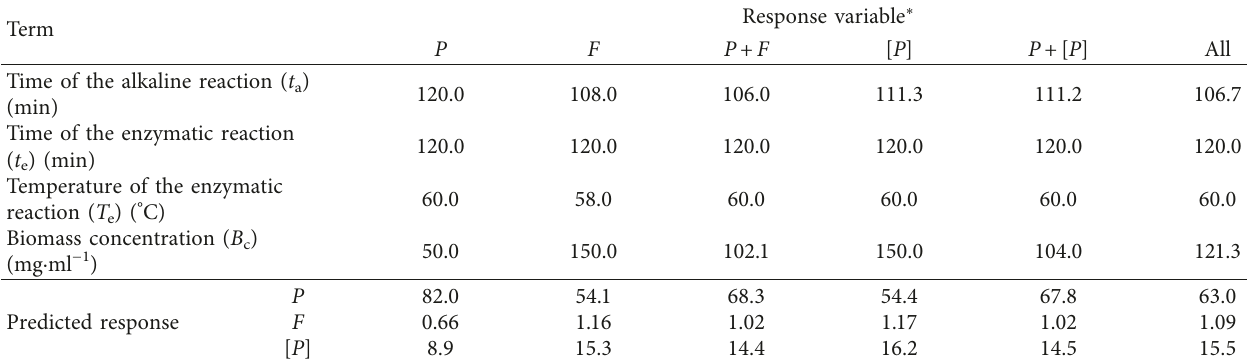
Table 4: Optimal values of the factors to maximize the different response variables.